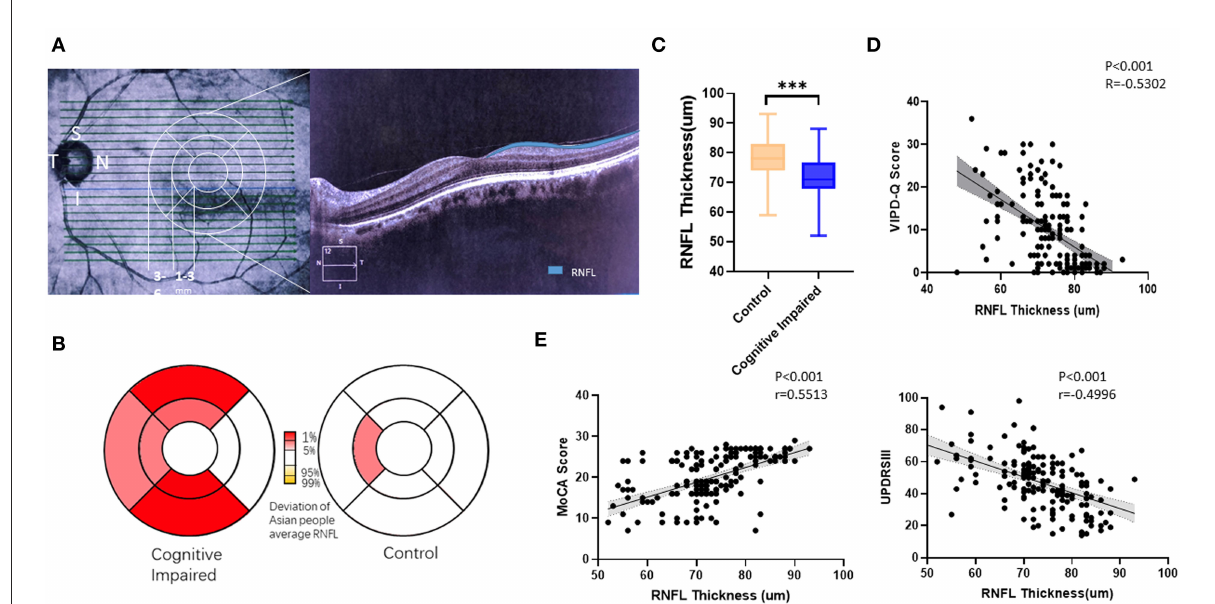
FIGURE3 Thinner RFNL in the ocular fundus was found in the cognitively impaired group. (A) Representative picture of a measured RNFL. (B) Deviation map of RNFL indicating thinner thickness. (C) PD patients with cognitive impairment had, on average, a thinner RNFL. (D) VIPD-Q was related to RNFL thickness. (E) RNFL was related to MoCA and UPDRSIII scores. ** p < 0.01, *** p < 0.001, and r = Pearson r. RNFL, retinal nerve fiber layer; PD, Parkinson’s disease; VIPD-Q, Visual Impairment in Parkinson’s Disease Questionnaire; UPDRS III, Unified Parkinson’s Disease Rating Scale Section III; MoCA, Montreal Cognitive Assessment.